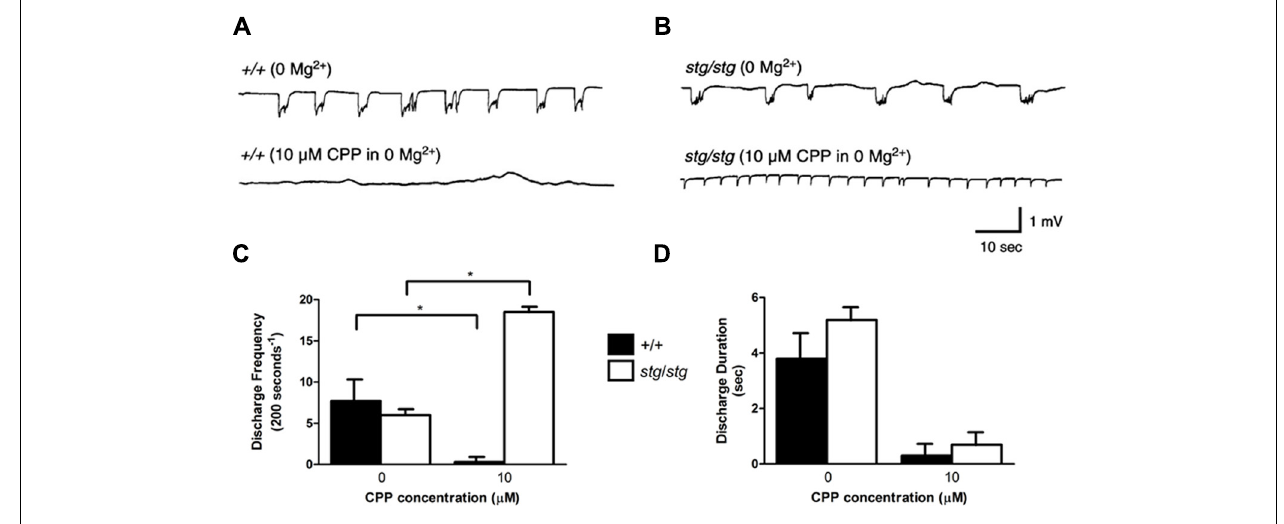
FIGURE 6 | Stargazer mutant paradoxical cortical excitability defect is maintained in vitro . (A) The frequency of spontaneous network discharges inWT cortical slices bathed in Mg 2 + -free solution (upper trace) is decreased in 10 μ M CPP (lower trace). (B) In contrast, discharge activity in stargazer cortical networks is increased following CPP